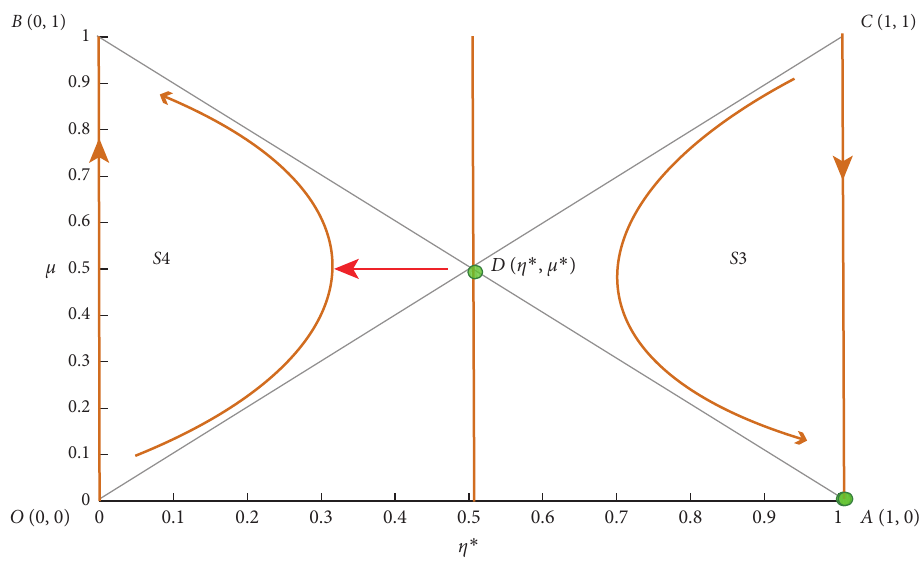
Figure 11: The evolution state of the